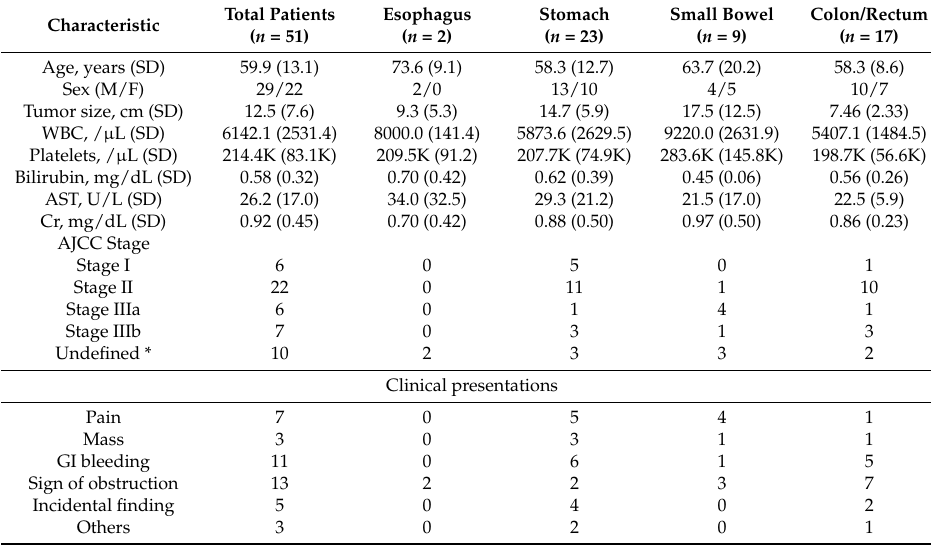
Table 1. Demographic data of 51 eligible patients.